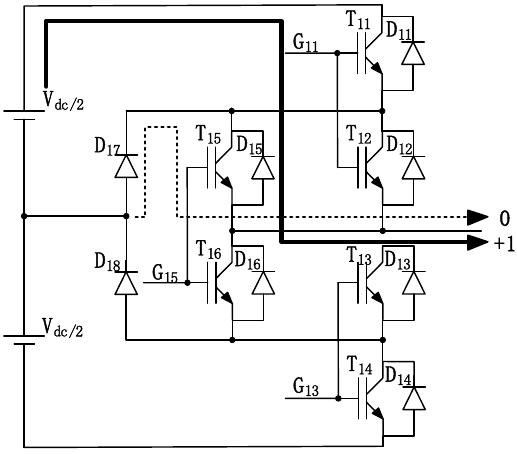
Figure 7. ID1 type ( α = +1, M = 1.15).